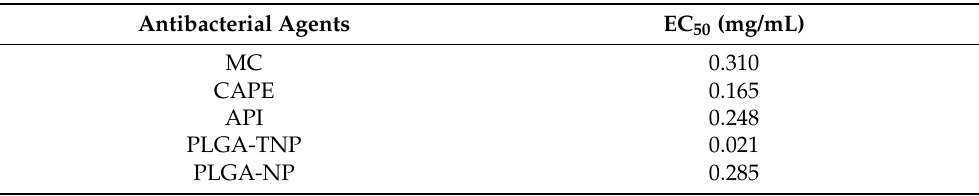
Table 1. EC 50 at different dosage forms of antibacterial agents against R. solanacearum and the quality of MC and CAPE